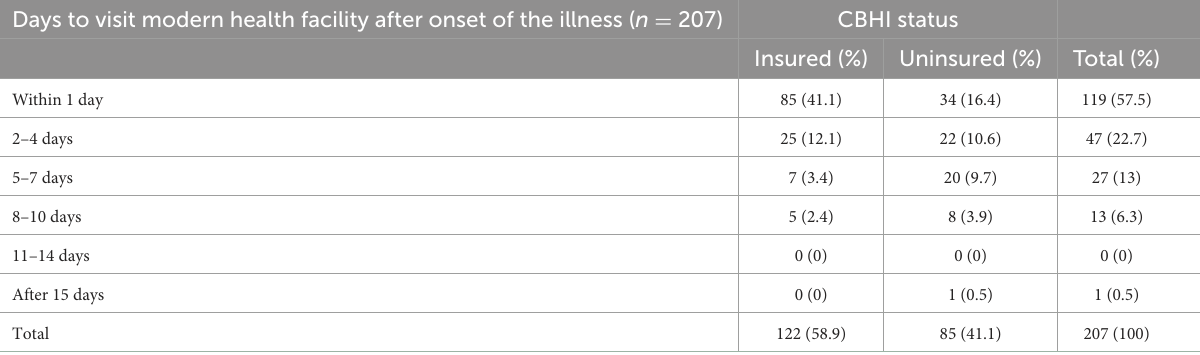
TABLE 2 Time taken in days to visit modern health facilities among households in the Gida Ayana district, Oromia Region, Ethiopia,